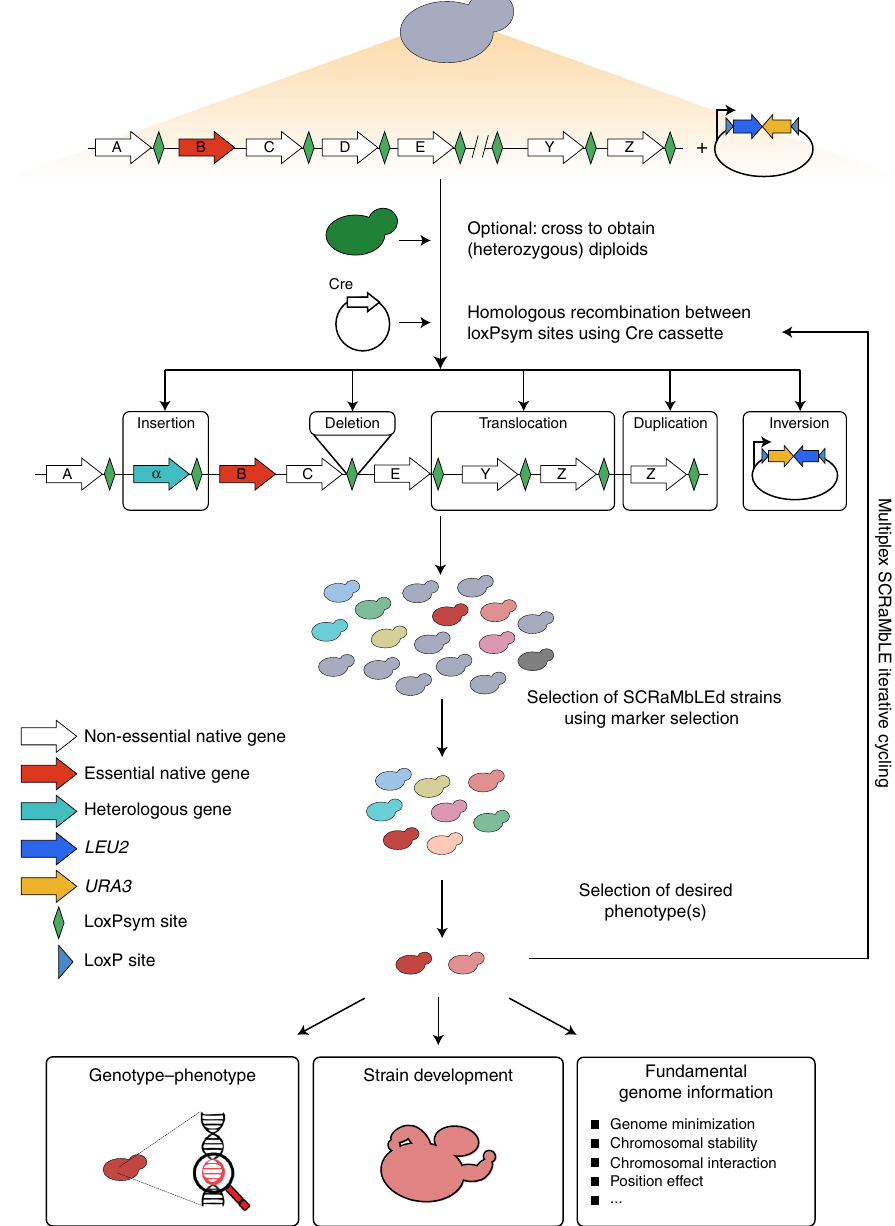
Fig. 1 Overview of the SCRaMbLE technology and its relevance for